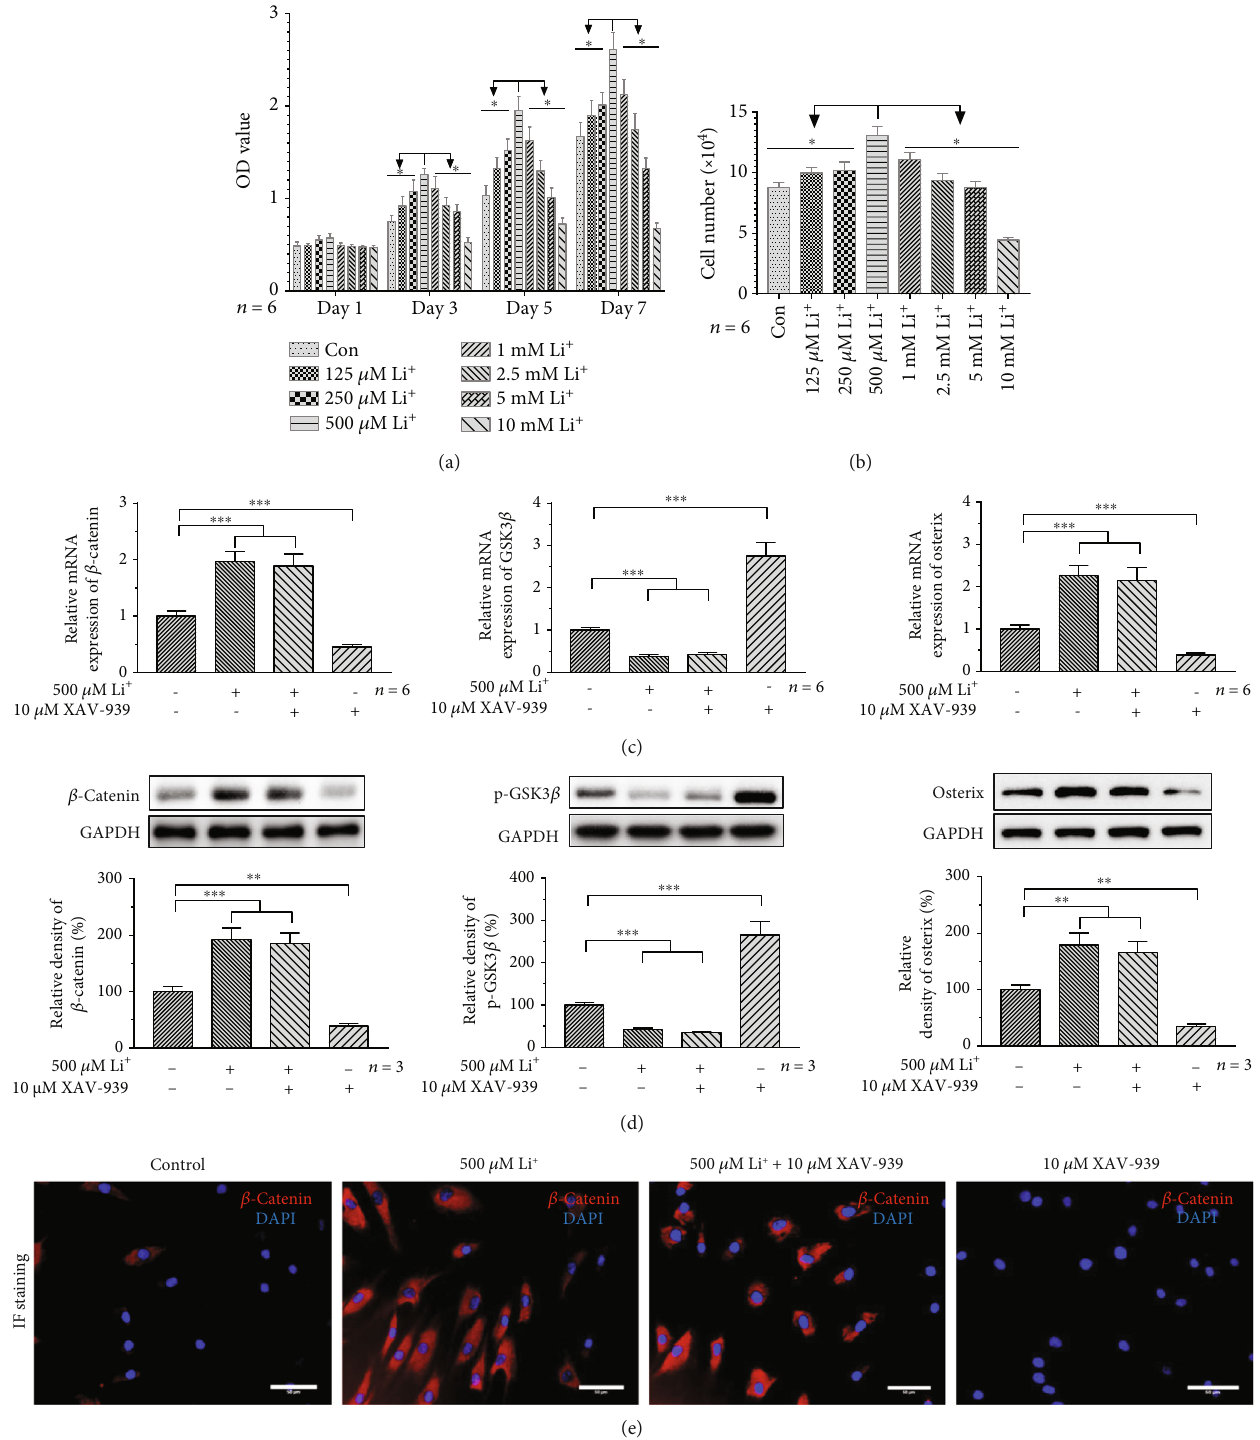
Figure 4: Lithium (500 μ M) can rescue the inhibited canonical Wnt signaling pathway. (a) MTT assay of BMSC proliferation under the stimulation of di ff erent lithium ion concentrations. The OD values of BMSCs were recorded on days 1, 3, 5, and 7 after stimulation. ∗ means P < 0 : 05 . (b) Cell count of BMSCs under the stimulation of di ff erent lithium ion concentrations for 7 days. Data are representative of six independent experiments, and ∗ means P < 0 : 05 . (c, d) The expression of the Wnt signaling pathway-related gene ( β -catenin, osterix, and p -GSK-3 β ) was measured by RT-qPCR and western blot in the BMSCs under the 500 μ M Li + , 10 μ M XAV-939, and 500 μ M Li + combined with 10 μ M XAV-939 stimulation for 7 days. The results are depicted as the mean ± SEM . ∗ P < 0 : 05 , ∗∗ P < 0 : 01 , ∗∗∗ P < 0 : 001 . (e) The immuno fl uorescence staining of β -catenin in BMSCs under di ff erent stimulations for 7